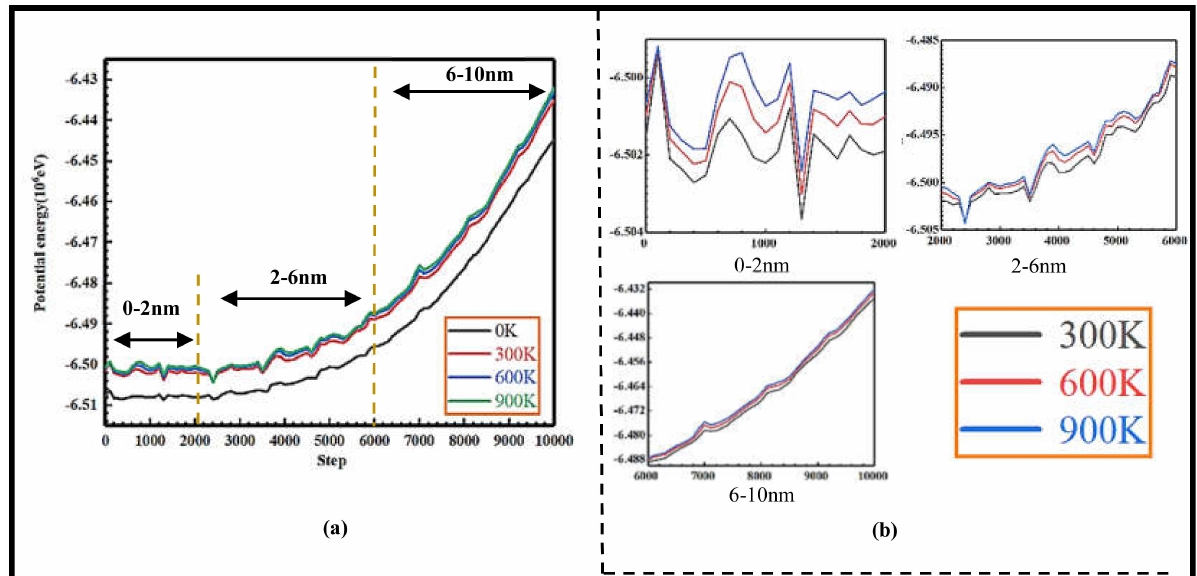
Figure 6. Graph of potential energy-step change at different temperatures. ( a ) Potential energy step relationship at low, normal medium high and high temperature, ( b ) Potential energy step relationship at normal, medium high and high